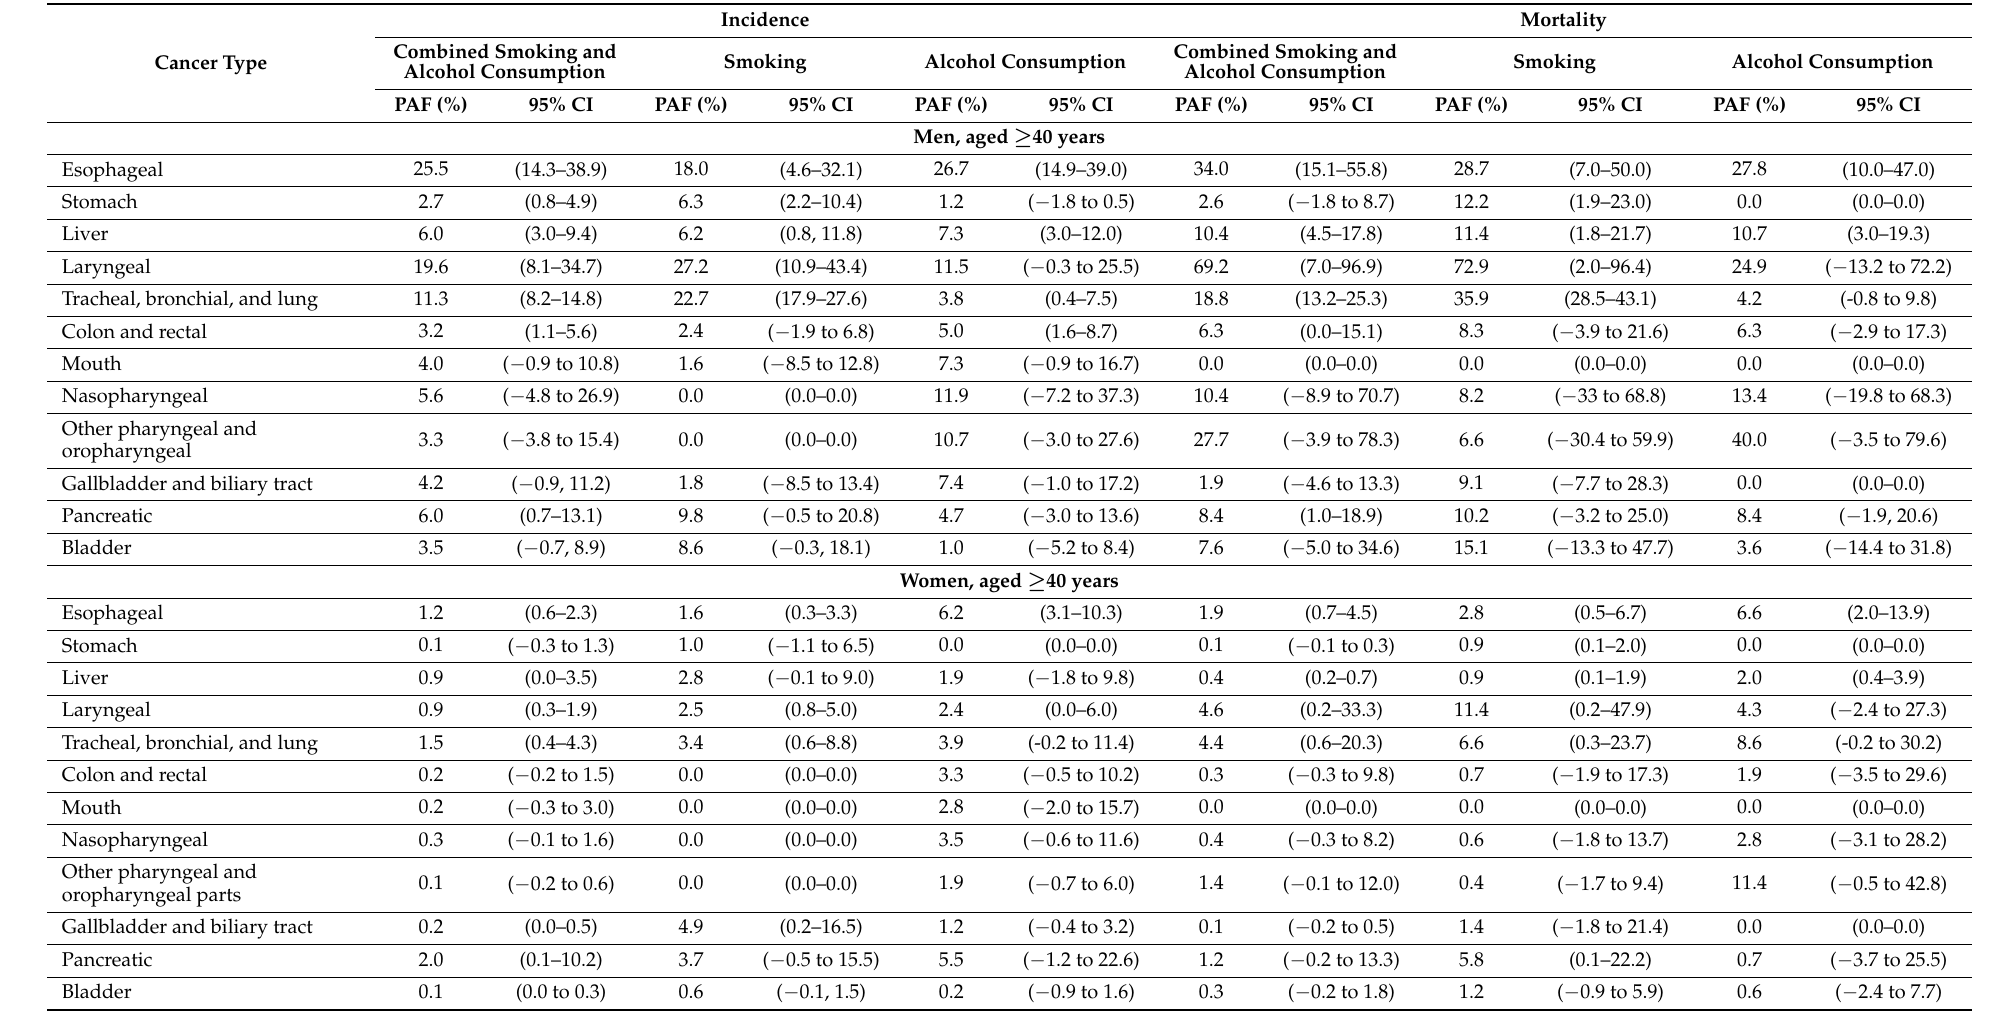
Table 4. PAFs for cancer in Korea according to